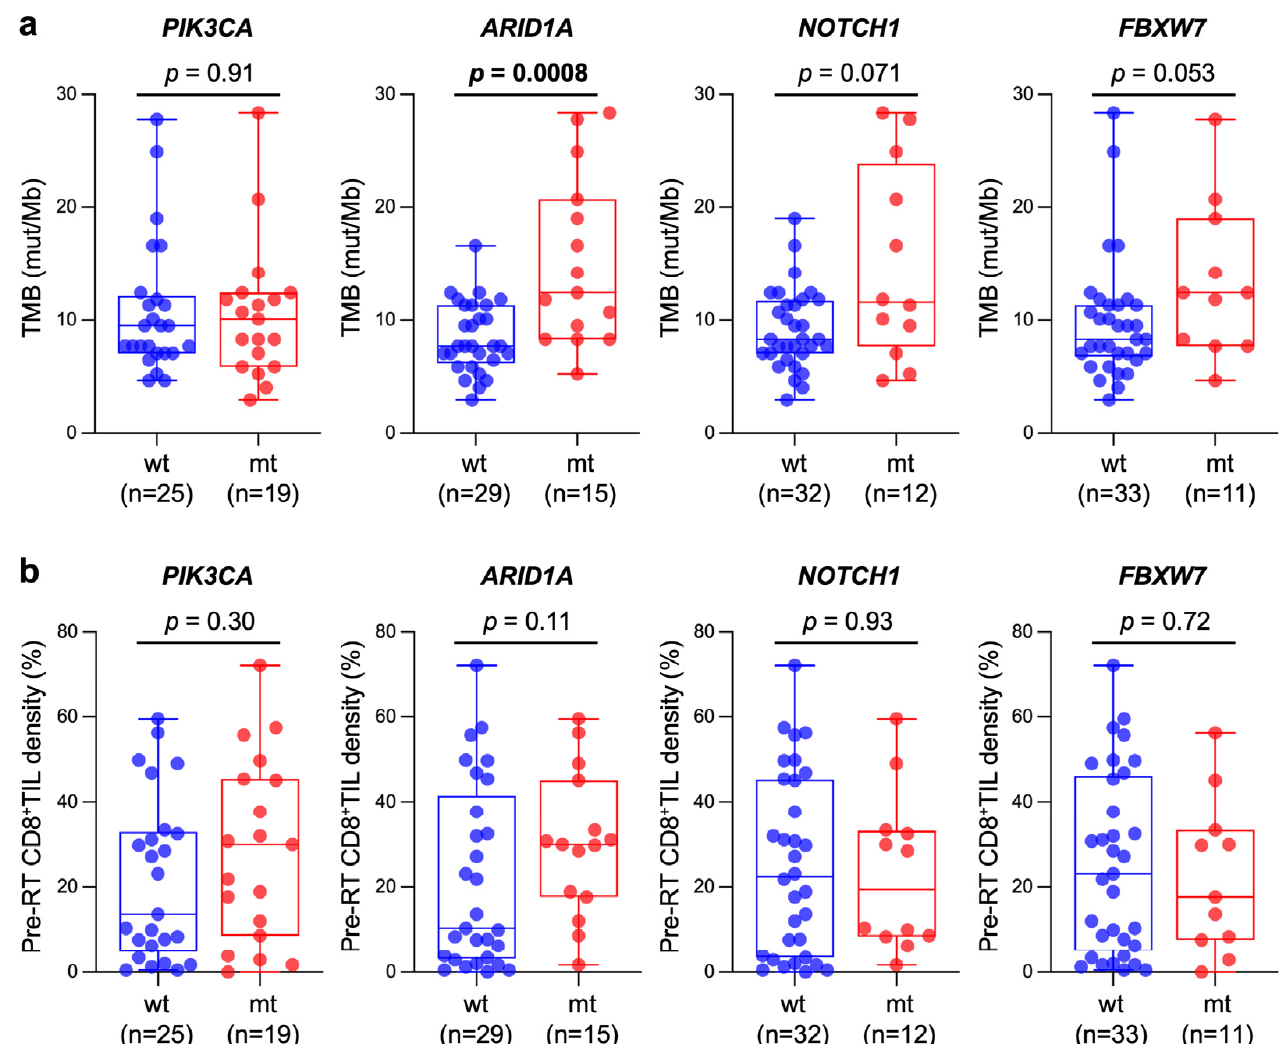
Figure 4. Box and whisker plots showing the association between TMB ( a ) or pre-RT CD8 + TIL density ( b ) and mutation status of genes frequently mutated in the study cohort (i.e., prevalence >20%); wt, wild-type; mt, mutant. p values assessed by the Mann–Whitney U test are shown.